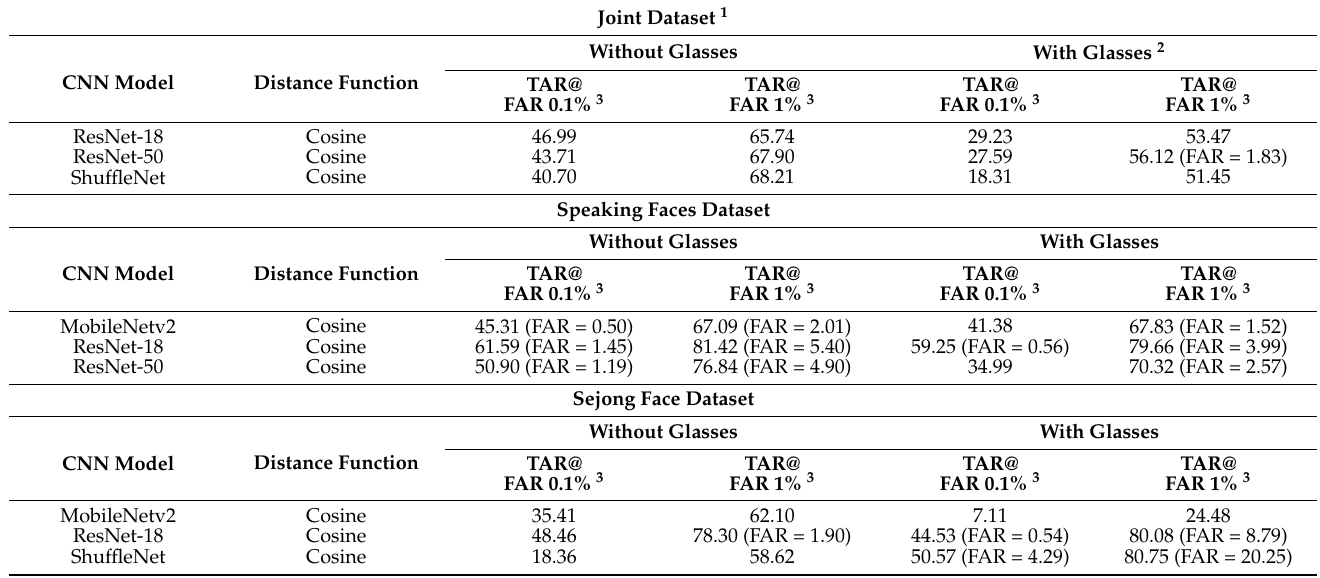
Table 4. Performance of Triplet algorithms for the joint 1 , Speaking Faces, and Sejong Face datasets for a visible anchor image.